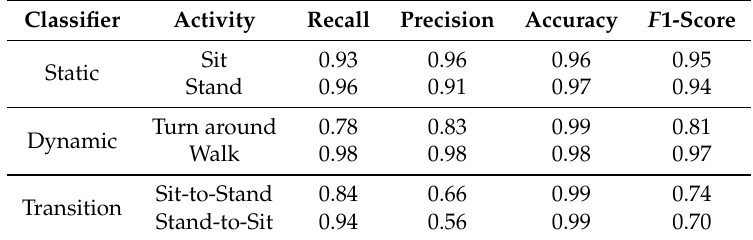
Table 5. Results of our classification model for static (sit, stand) and dynamic (walk, turn around) activities, as well as transitions (sit-to-stand, stand-to-sit). Classifier Activity Recall